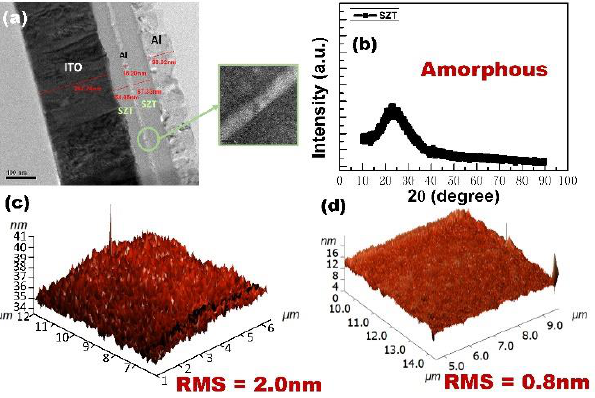
Figure 2. ( a ) TEM image of cross-sectional SZT/Al/SZT tri-layered thin films sandwiched between ITO BE and Al TE. ( b ) XRD spectrum of SZT thin film. AFM image of ( c ) SZT and ( d ) SZT/Al/SZT tri-layered thin films.